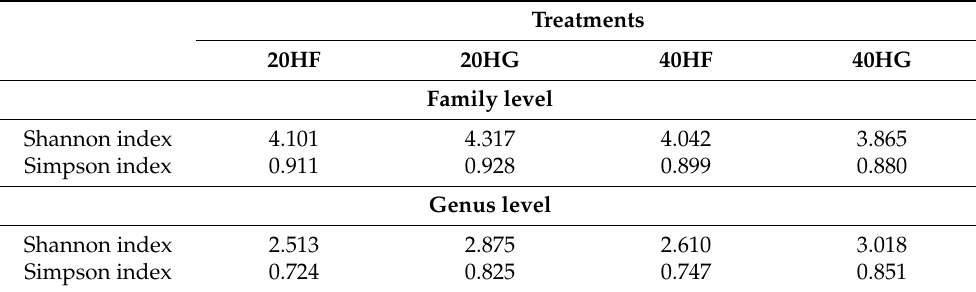
Table 6. Alpha diversity of ruminal bacteriome in family and genus